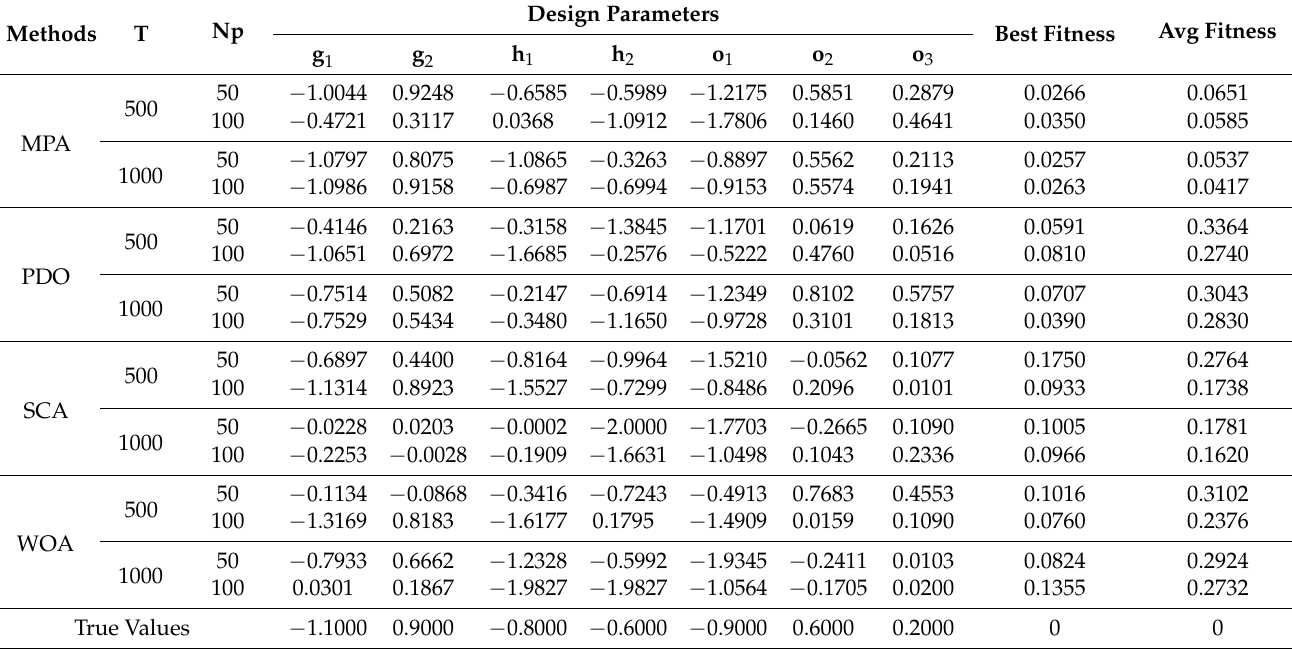
Table 6. Estimated weight analysis w.r.t generation and population sizes at 10 dB noise for case study